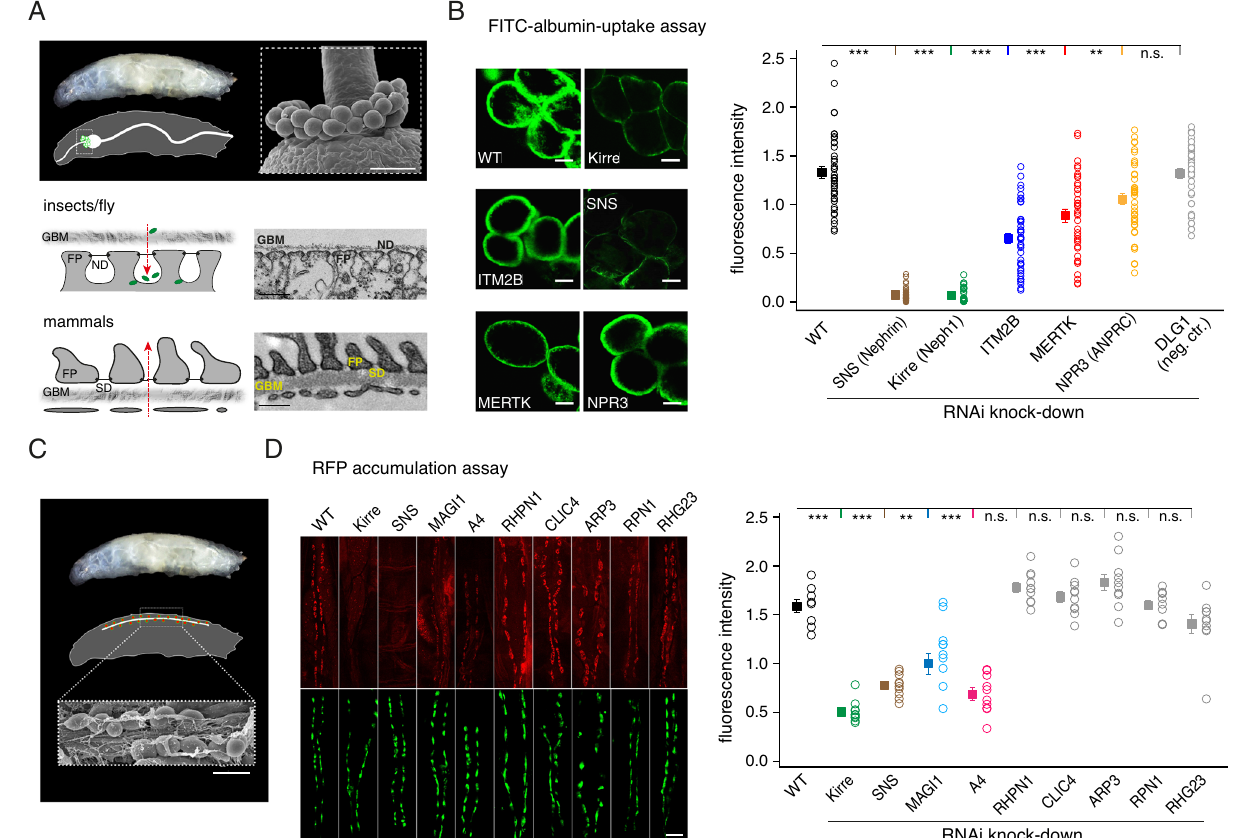
Fig. 4 | Impaired fi ltration resulting from knock-down of the identi fi ed SD constituents MERTK, ITM2B, A4, MAGI1, and ANPRC in Drosophila nephro- cytes.A Analogyoftherenal fi lterin fl ies(Garlandcellnephrocytes,upper,middle panel) and mammals (podocytes, lower panel) is depicted by EM sections and schemes; red arrows denote the fi ltration pathways. Upper panel: scanning EM of nephrocytesfrom fl ylarvae.Scalebaris40 µ m,resultisrepresentativeofatleast10 experiments. Note the conserved building of the SD in both species, re fl ected by FP, GBM, and S/ND (scale bars are 250nm). B Left panel: Representative fl uores- cence images obtained from nephrocytes without (WT, control) and with RNAi- mediated knock-down of the indicated proteins in the FITC-uptake assay. Scale barsare10 µ m.Rightpanel:ResultsoftheFITC-uptakeassayperformedin fl ieswith and without protein knock-down. Data points are results from individual fl ies, squaresaremean±SEMof40(WT),33(KIRRE),38(SNS),39(ITM2B),38(MERTK), 40(NPR3),and36(DLG1)experiments.ValuesforKIRRE,SNS,ITM2B,MERTK,and different from WT (n.s.). Note the distinct impairment of FITC-uptake determined